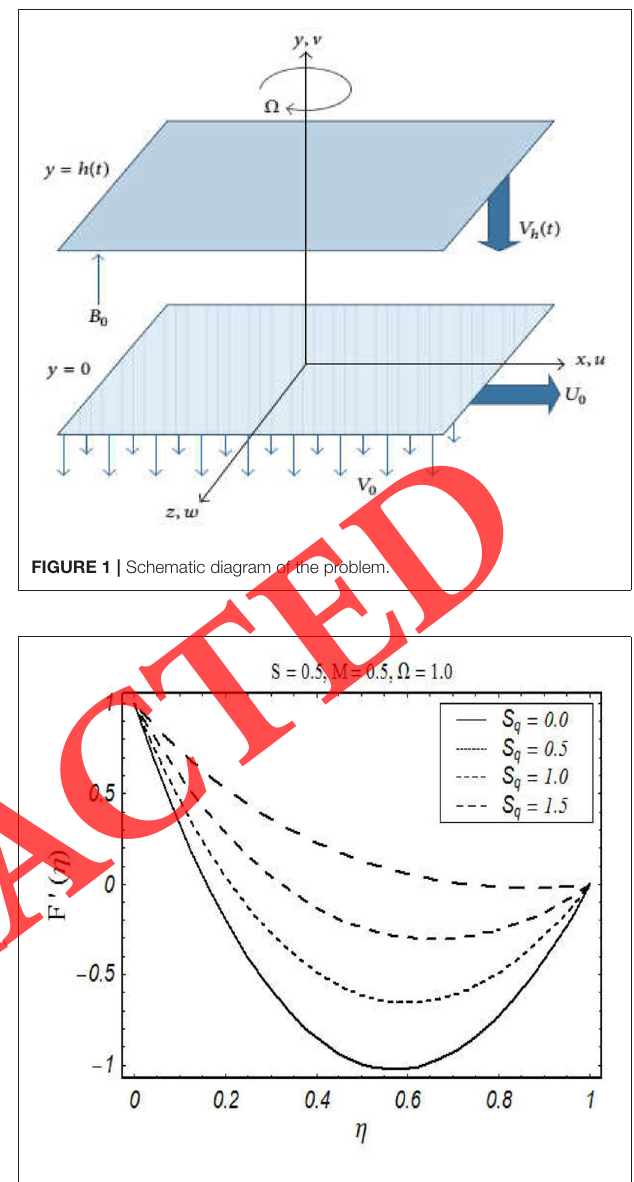
FIGURE 2 | Sketch of velocity distribution F ′ (η) for squeezing number S q